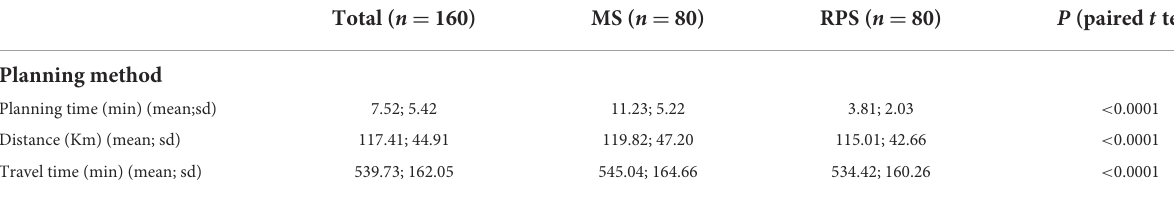
TABLE 3 Comparing the planning method: MS vs.